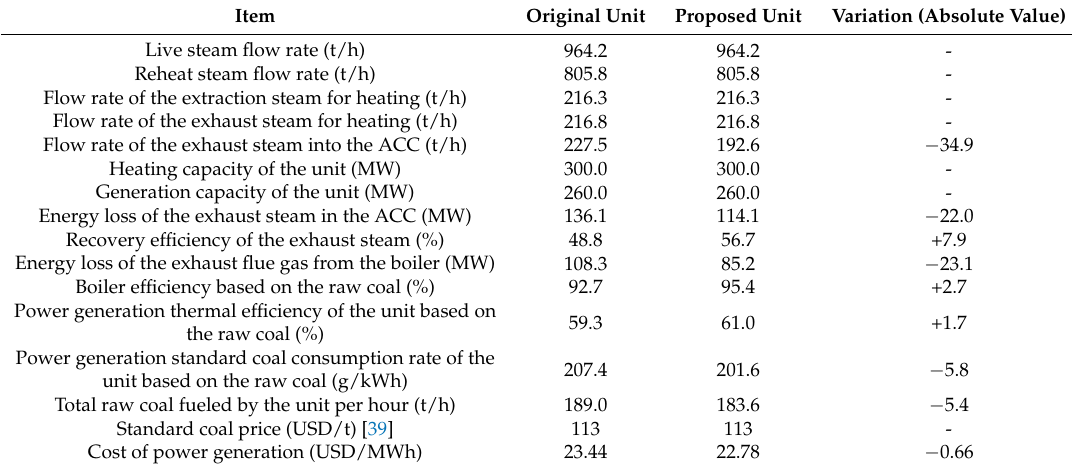
Table 4. Overall performances of the original HBP-CHP unit and the proposed HBP-CHP unit.